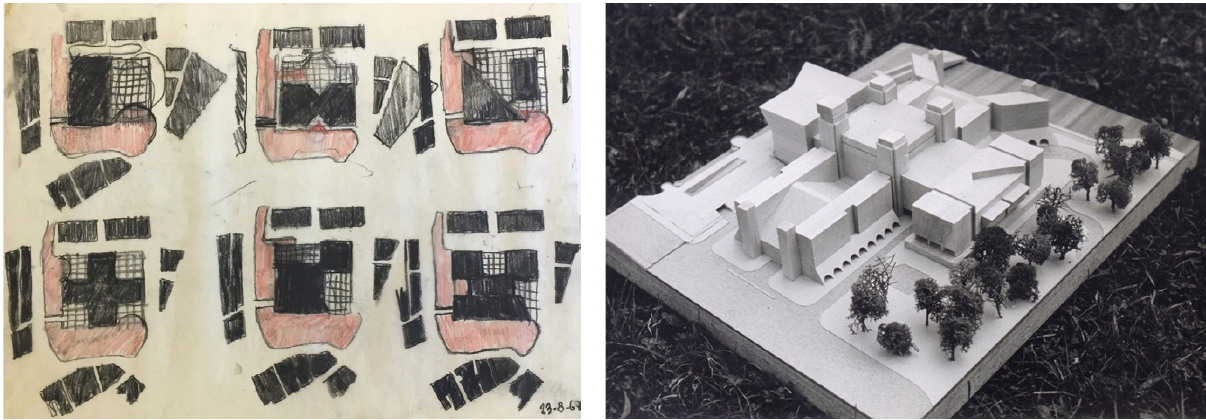
Figure 6. Six possible solutions for the city hall (23-08-1967) (Marques da Silva Foundation, RHF archive)